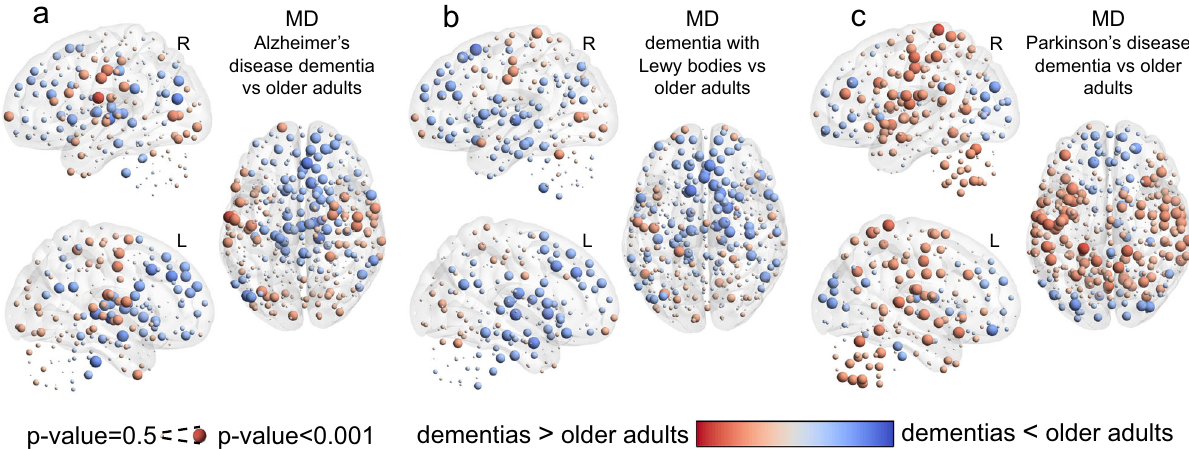
Fig. 7 Neurodegenerative dementia effects of modular dissociation (MD). a MD differences between older adults (OA) and Alzheimer ’ s disease dementia (ADD). b MD differences between older adults (OA) and dementia with Lewy bodies (DLB). c MD differences between older adults (OA) and Parkinson ’ s disease dementia (PDD). Results were assessed with non-parametric permutations (5000) after regressing out covariates of no interest. Only results for MD-PDD survived correction for multiple comparisons at a p -value <